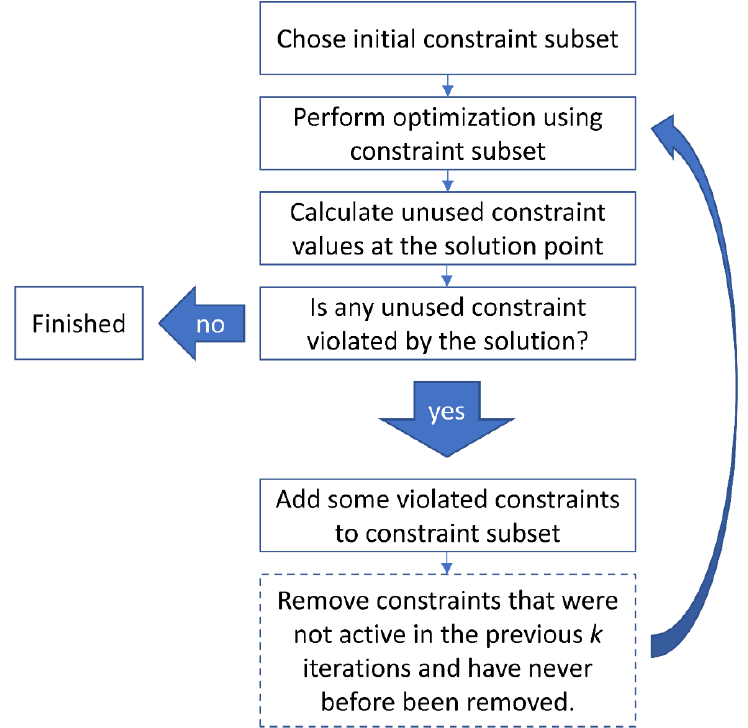
Figure 1. Flowchart of the iterative solution algorithm. The algorithm initially selects a small subset of all healthy ( = constraint) voxels to be considered during the targeted heating calculation. After performing the optimization, the resultant specific absorption rate (SAR) in the unconsidered voxels is calculated to find regions where the found solution violates the constraints (i.e., leads to undesired heating in healthy regions). A small number of the healthy voxels experiencing the strongest heating are added to the constraint subset and the optimization is repeated. This process is iterated until no further constraints are violated by the solution. The last step in the dashed outline is optional and only required if the number of constraints has increased to a level that significantly impacts each iterative solution runtime.